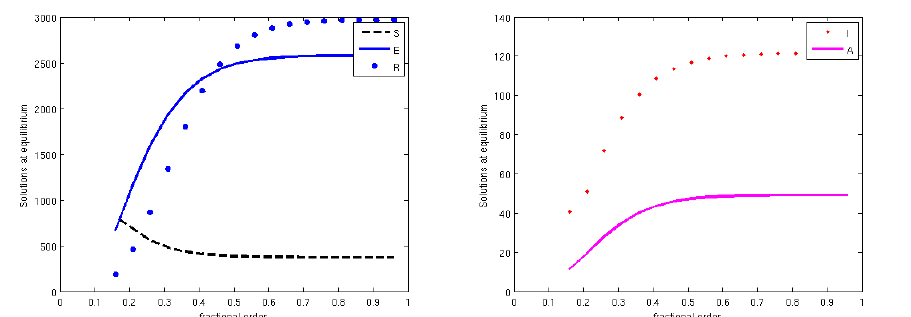
Figure 5. The model behavior for R 0 = 1.1421 > 1 as q varies in [ 0,1 ] . ( Left ) exposed and recov- ered; ( Right ) susceptibles, infected and asymptomatic. The situation corresponds to the endemic equilibrium P ∗ . The parameter values are the same of Figure 2.